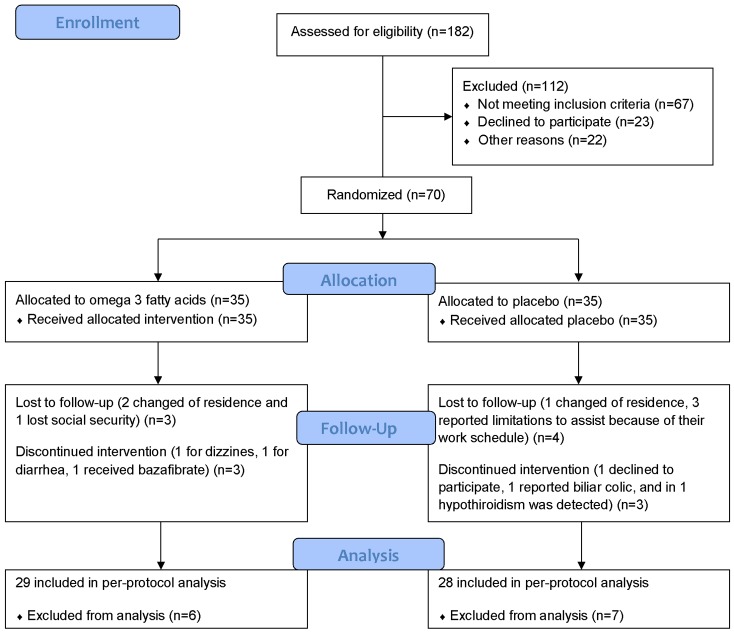
Enrollment, randomization, and follow-up of study patients.